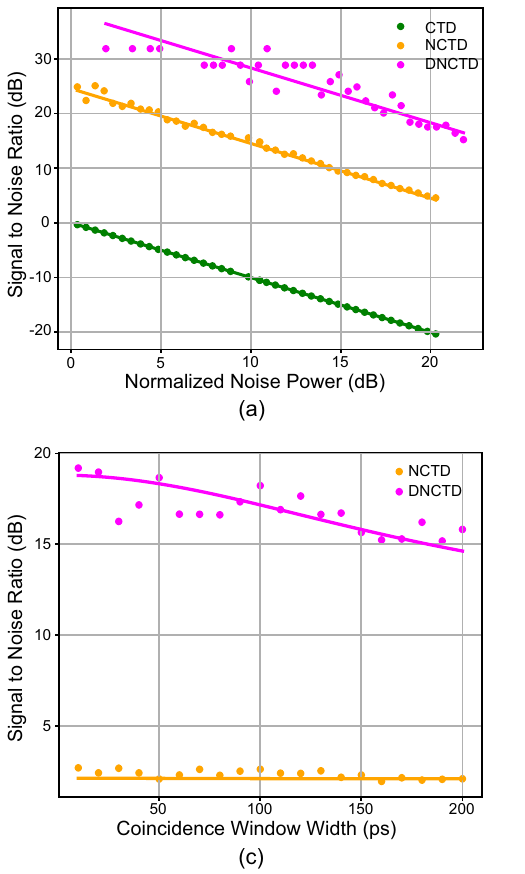
Fig. 3 | Signal-to-noise ratio comparison of classical target detection (CTD), non-classical target detection (NCTD), and dispersed non-classical target detection (DNCTD) protocols. a Signal-to-noise ratio for varying noise power. b Signal-to-noise ratio for varying probepower. c SNRasa function of coincidence